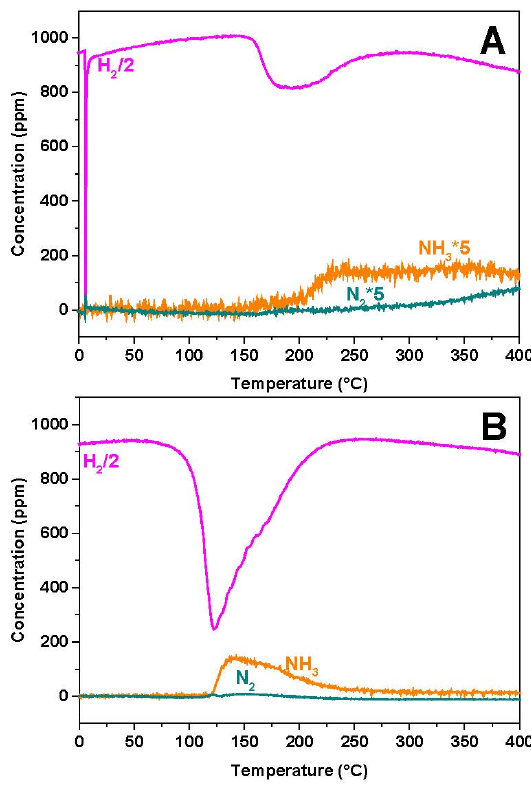
Figure 7. H 2 ‐ TPSR experiments with H 2 (2000 ppm) from 40–400 °C (4 °C/min) after NO/O 2 adsorption Figure 7. H 2 -TPSR experiments with H 2 (2000 ppm) from 40–400 ˝ C (4 ˝ C/min) after NO/O 2 at 350 °C over ( A ) Rh ‐ BaO/Al 2 O 3 and ( B ) Pt ‐ BaO/Al 2 O 3 (rig#3). adsorption at 350 ˝ C over ( A ) Rh-BaO/Al 2 O 3 and ( B ) Pt-BaO/Al 2 O 3